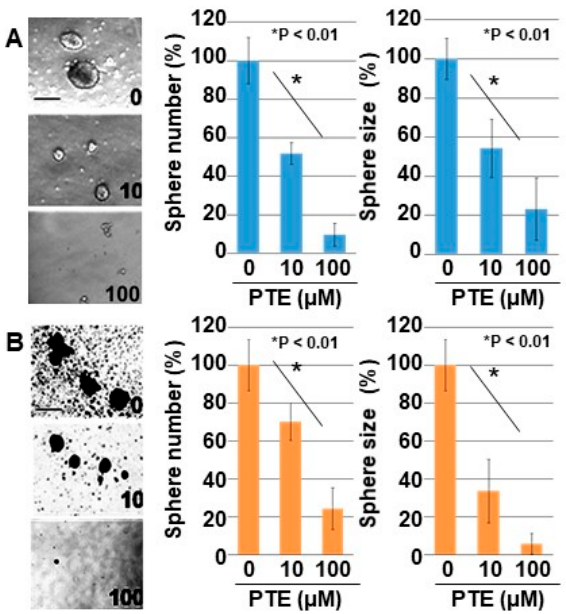
Figure 2. Effect of PTE on sphere formation in cancer cell lines. Sphere formation was examined in 10,000 cells with or without PTE treatment for 7 days. ( A ) CT26 cells. ( B ) HT29 cells. Pictures were images of phase-contrast microscopy. Error bar, standard deviation from three independent examinations. Statistical difference was calculated by ordinary analysis of variance. Scale bar, 50 μ m. TE, pterostilbene.